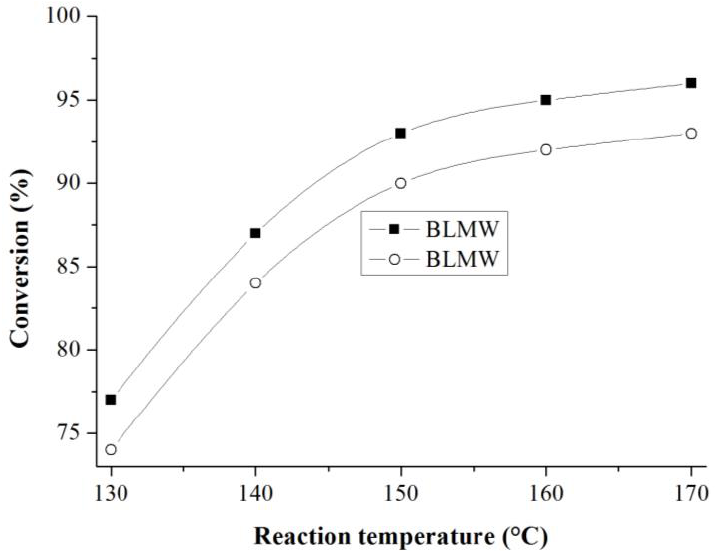
Figure 7. Effect of reaction temperature (°C) on the % conversion during DDPO esterification. Reaction conditions: molar ratio of DDPO:EtOH: 1:30, catalyst amount: 5.0%, and reaction time: 2 h.